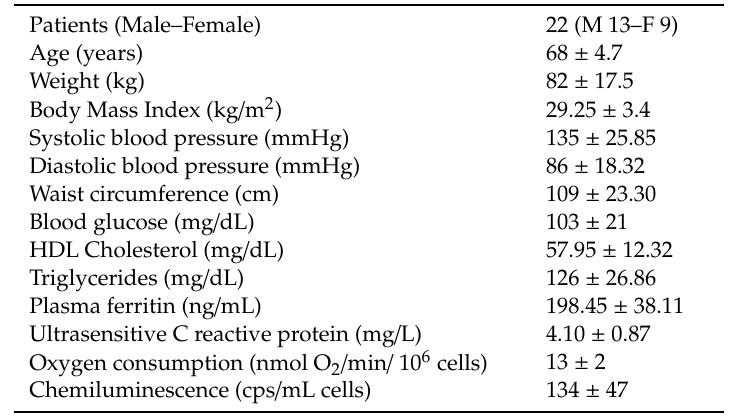
Table 1. Patient average baseline data.